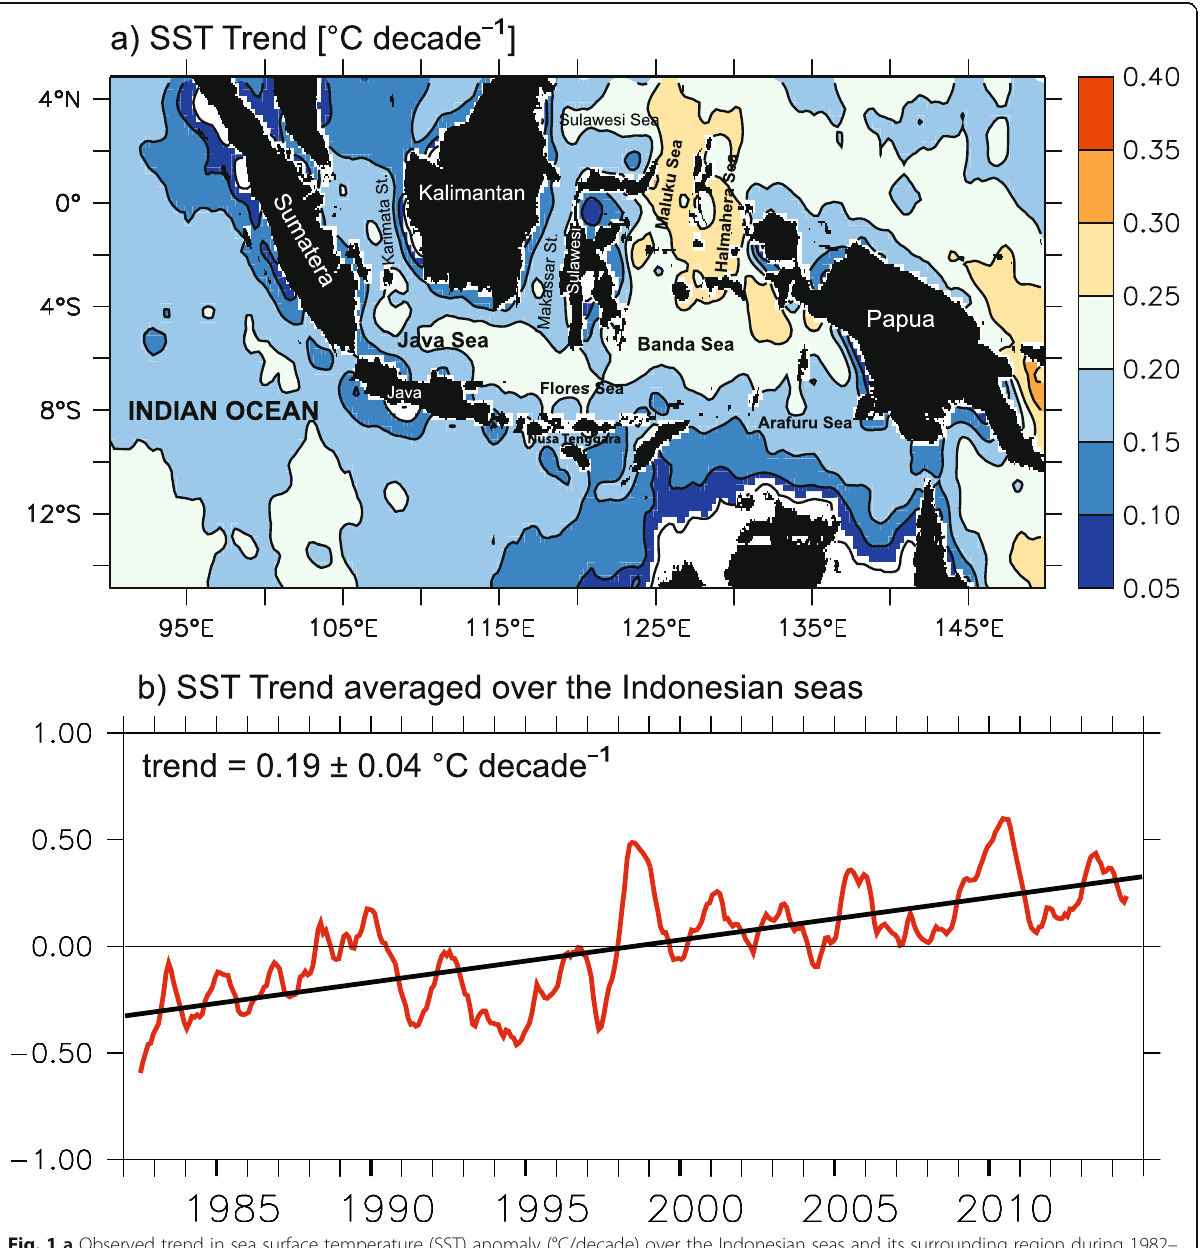
Fig. 1 a Observed trend in sea surface temperature (SST) anomaly (°C/decade) over the Indonesian seas and its surrounding region during 1982 – 2014. Significant values above 95% confidence level are shaded. b Time series of area-averaged SST anomaly over the Indonesian sea ( red – °C) and its corresponding linear trend ( black-line – °C/decade) for 1982 –